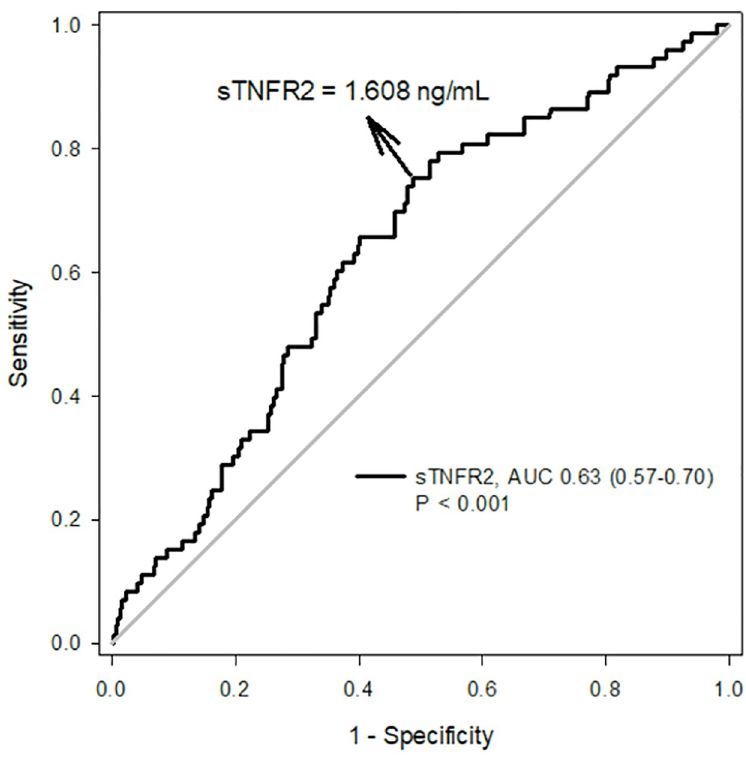
Fig 1. Receiver operating characteristic curves of soluble tumor necrosis factor receptor 2 (sTNFR2) in patients with type 2 diabetes.